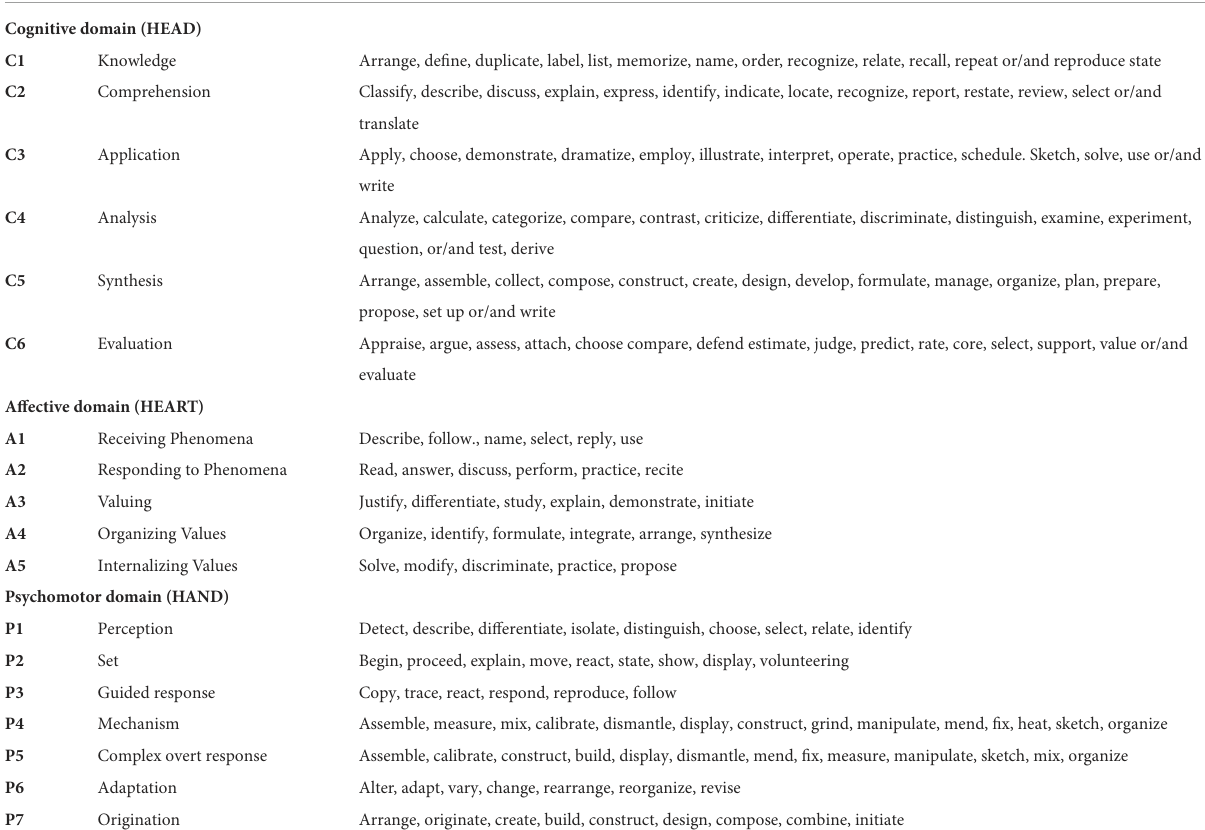
Cognitivedomain